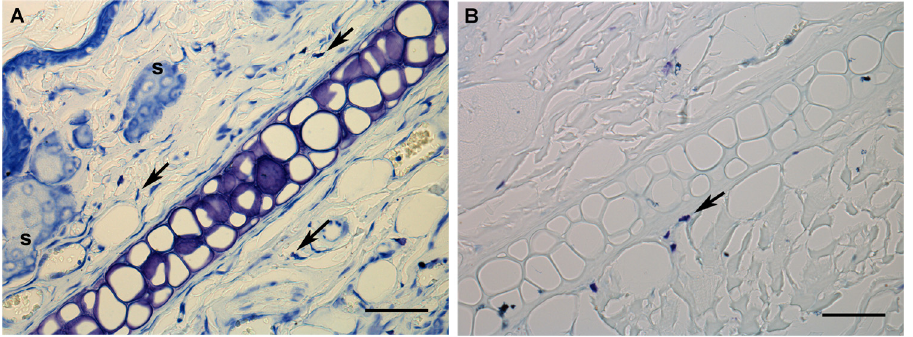
Fig 1. Toluidine blue staining in ear sections subjected (B) or not (A) to hyaluronidase digestion. The arrows indicate mast cells. S, sebaceous glands. Bar = 50 μ